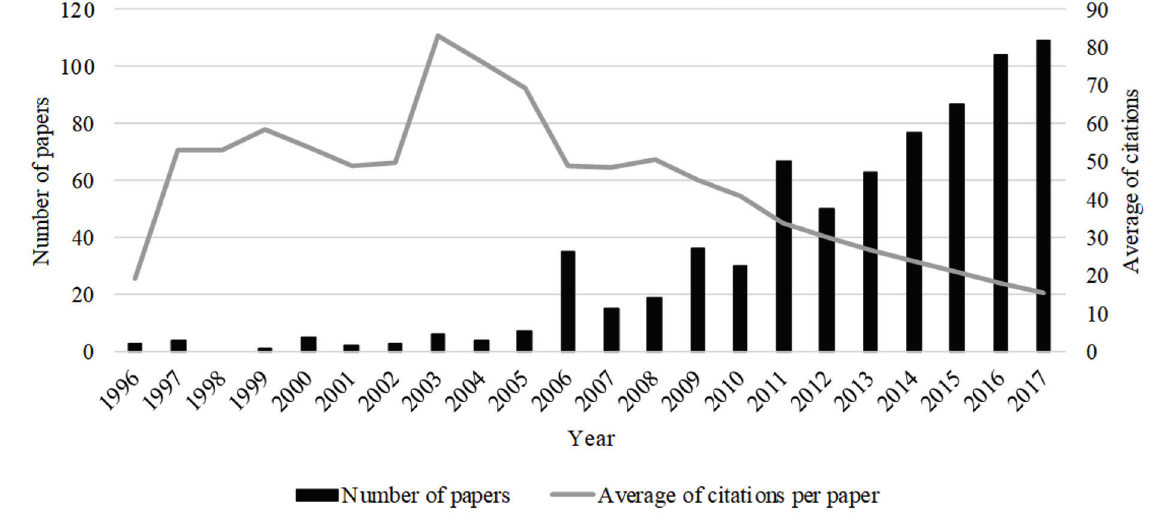
Figure 1 - Evolution of the number of papers and average citations per paper on DSM from 1996 to